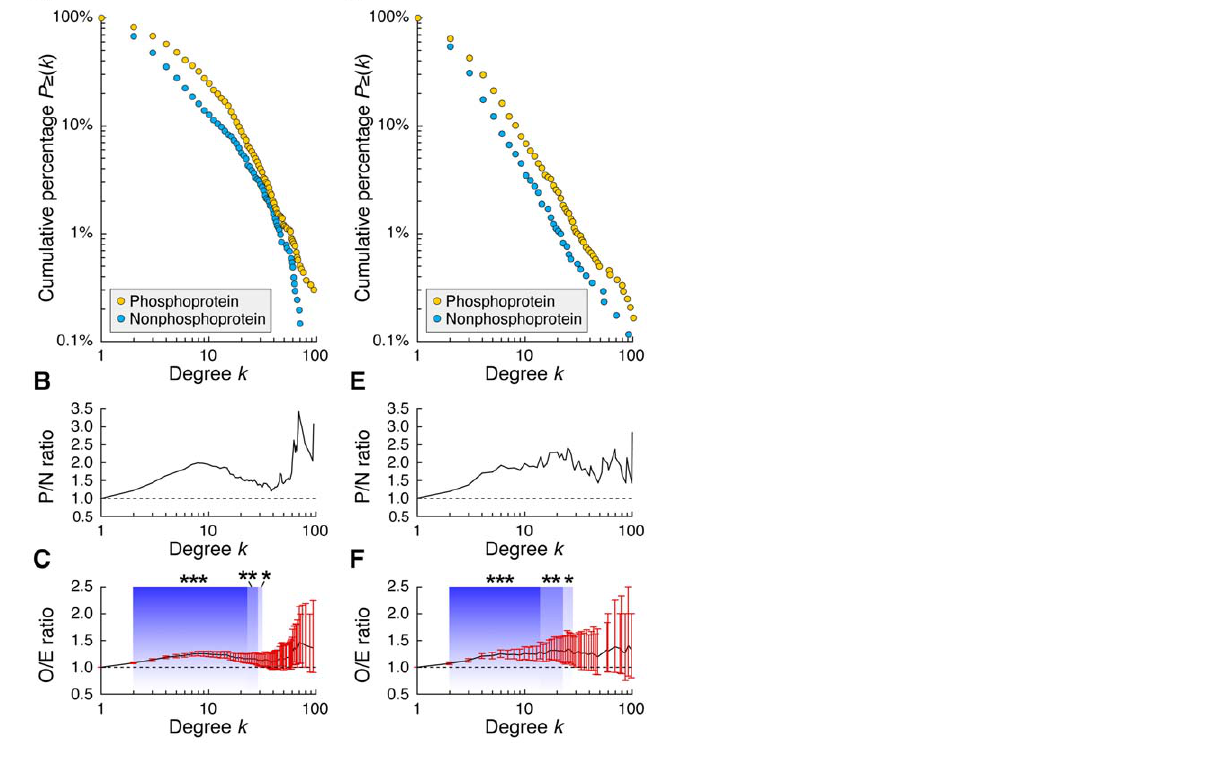
Figure 3. Node degree distributions of phosphoproteins and nonphosphoproteins in the phospho-PPI data sets of ‘‘ALL’’ (A–C) and ‘‘Y2H’’ (D–F). ( A,D ) Cumulative probability distribution of node degrees. For each group of phosphoproteins and nonphosphoproteins, circles represent proportions of proteins with more than the k interacting partners indicated on the horizontal axis [ P $ ( k )]. ( B,E ) P to N (P/N) ratio, where P and N are P $ ( k ) of phosphoproteins and nonphosphoproteins, respectively. ( C,F ) O to E (O/E) ratio, where O is P $ ( k ) of phosphoprotein and E is that expected from negative controls generated by node label shuffling (N=10,000). For each node degree level, line graph and bar represent mean and two-sided 95% confidence intervals, respectively. Background colors and asterisks denote statistical significance over neutral O/E value of 1.0 (* P , 0.05, ** P , 0.01, *** P , 0.001).